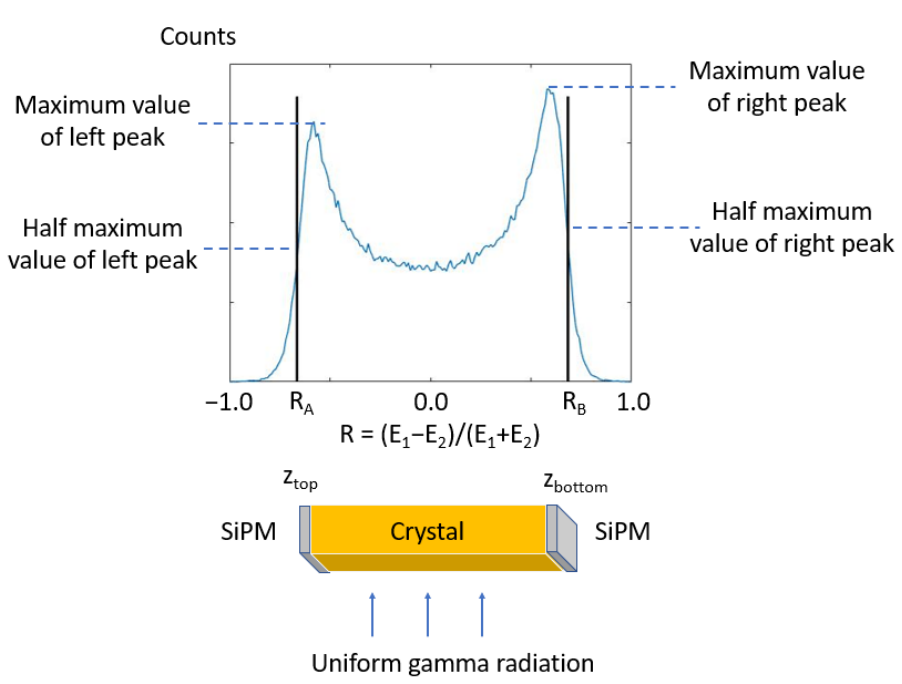
Figure 3. Illustration of z position calibration method.